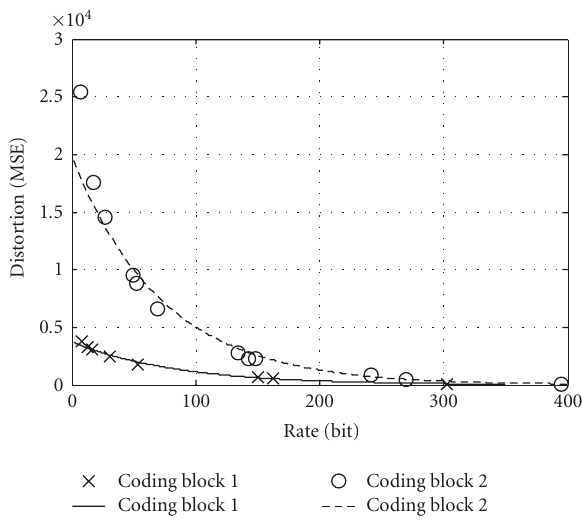
Figure 3: R-D models for coding blocks in a wavelet video